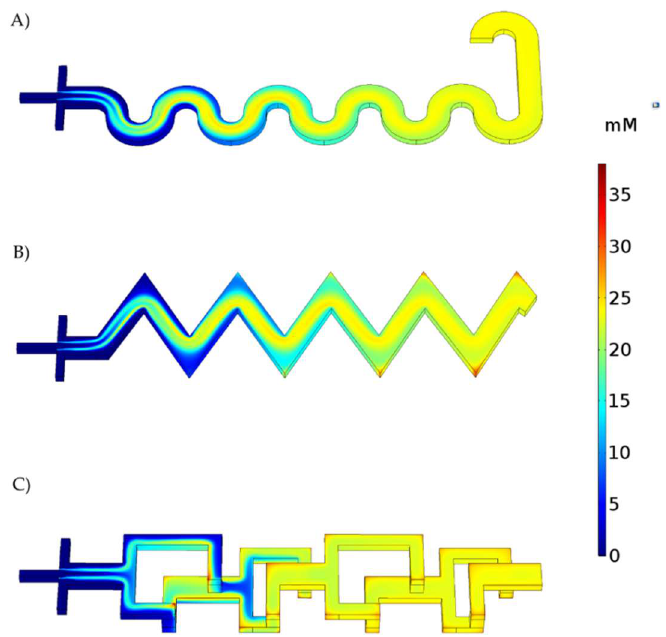
Figure 7. Fe 3 O 4 NP concentration profiles during transit along each micromixer. ( A ) Serpentine − based (SB) micromixer, ( B ) Triangular − based (TB) micromixer, and ( C ) 3D − based (3DB) micro- mixer.